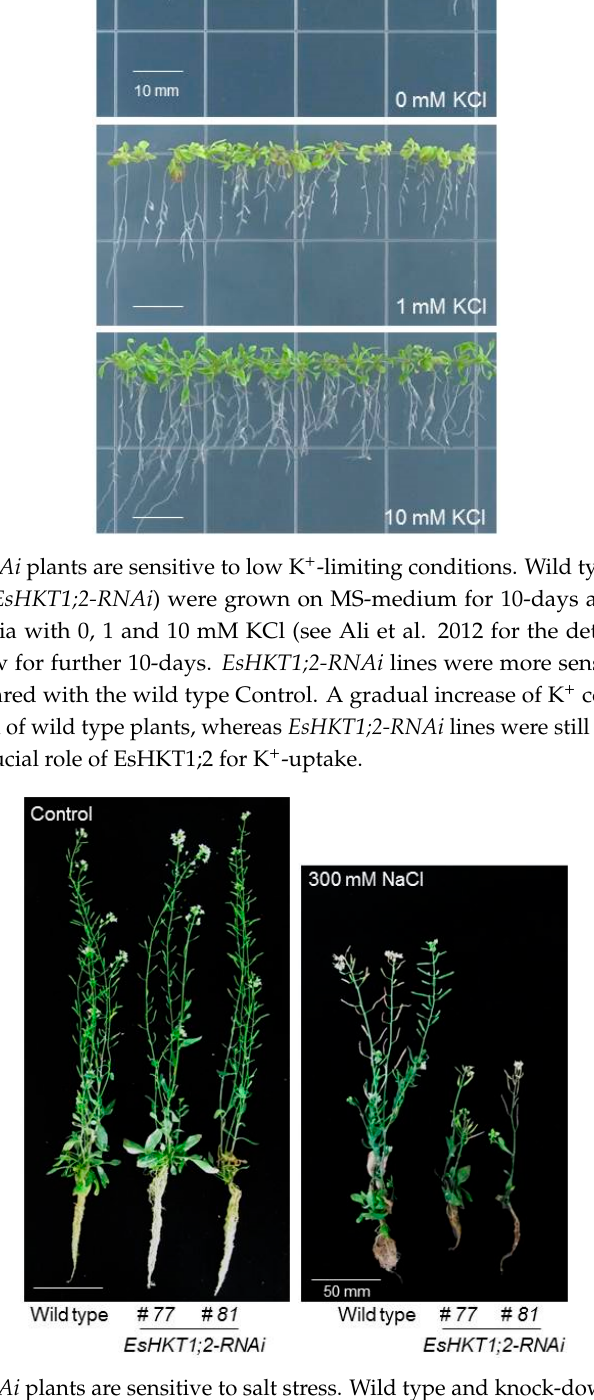
Figure 4. EsHKT-RNAi plants are sensitive to salt stress. Wild type and knock-down lines of EsHKT1;2 ( EsHKT-RNAi ) were grown on MS-medium for 2-weeks and then transferred to inert soil (porous soil, see Ali et al. 2012 for details) and grown for further 3-weeks. Plants were then treated with 300 mM NaCl for another 3-weeks period, twice a week (control represents untreated plants). EsHKT-RNAi lines were more sensitive to salt stress as compared with wild type Control.